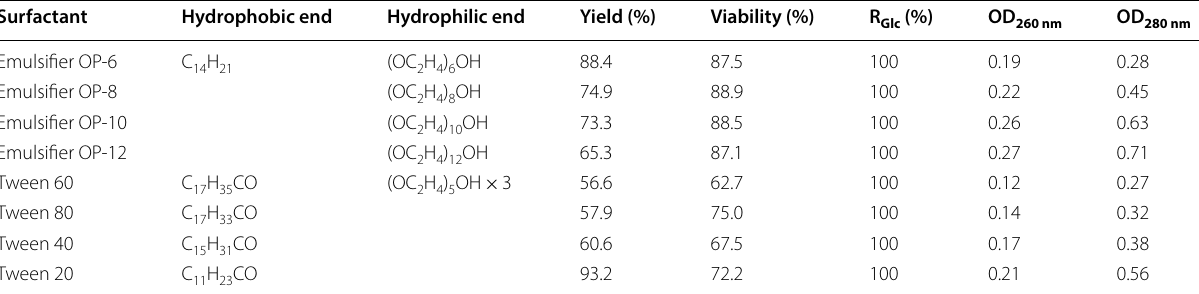
Cultural condition: 10 g L − 1 glucose; 150 g L − 1 wet cell; 0–2.0 mmol L − 1 surfactants; 20 mL Tris–HCl buffer (50 mmol L − 1 , pH8.0); 32 °C; 200 r min − 1 ; anaerobic; 24 h